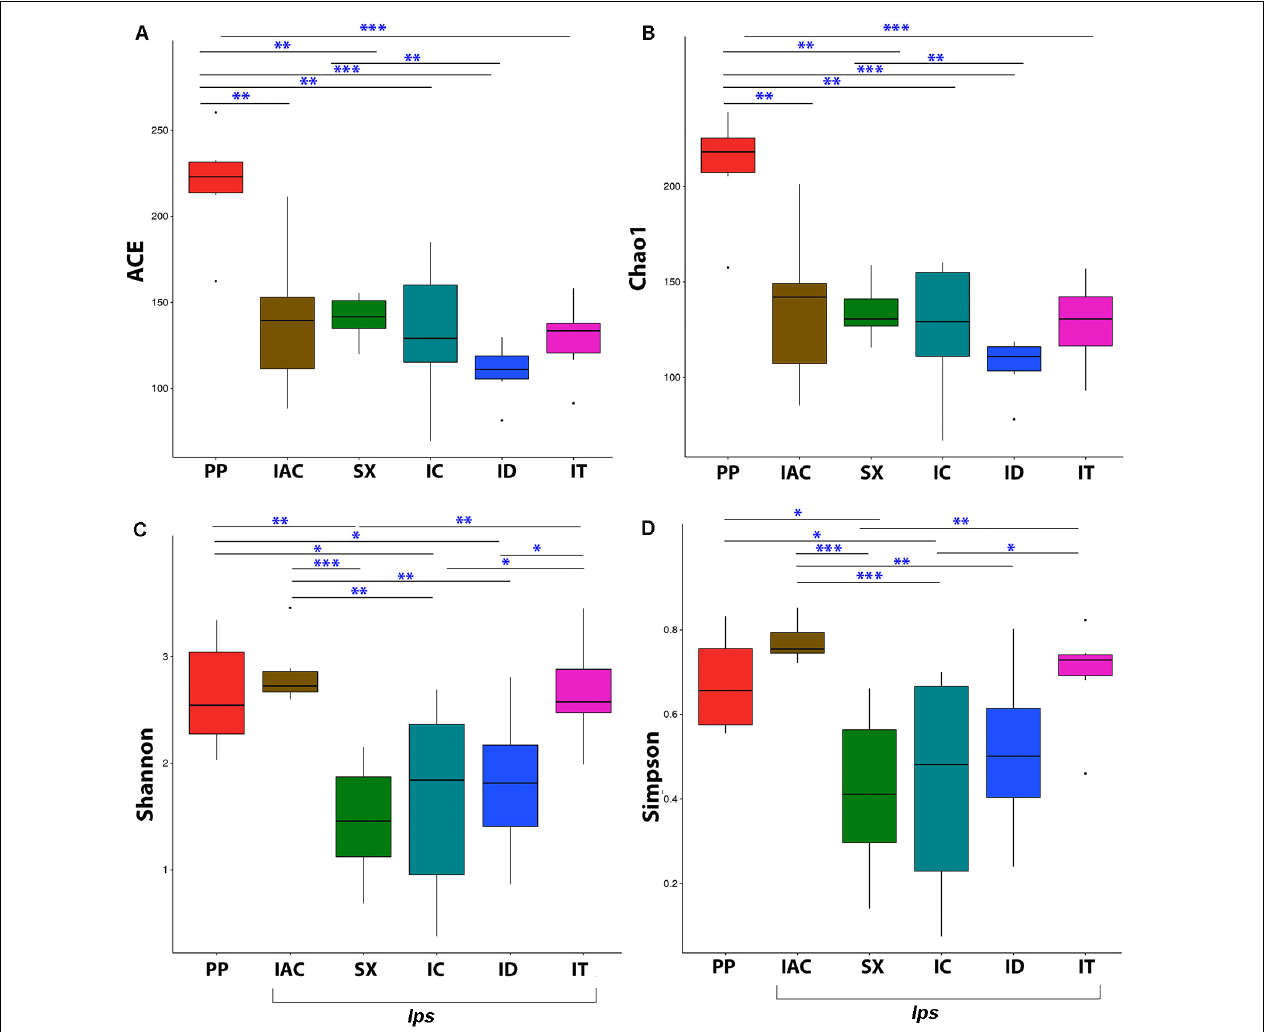
FIGURE 3 | Alpha diversity indices representing the fungal community richness and diversity among the six different bark beetles. The expected richness estimated by (A) ACE analysis and (B) Chao1 analysis indicated significant variation between Polygraphus poligraphus (PP) and other spruce feeding beetles while no such difference in community richness was observed between pine feeding beetles (IAC and SX). The gut fungal diversity illustrated by (C) Shannon index and (D) Simpson index documented similar diversity measures between Polygraphus poligraphus (PP) and Ips typographus (IT) compared to Ips duplicatus (ID) whereas Ips acuminatus (IAC) represented higher diversity than Ips sexdentatus (SX). The statistical analysis for the significant differences between groups is done by Wilcoxon signed-rank test where “ ∗ ” denotes p < 0.05, “ ∗∗ ” designates p < 0.01 and “ ∗∗∗ ” resembles p <